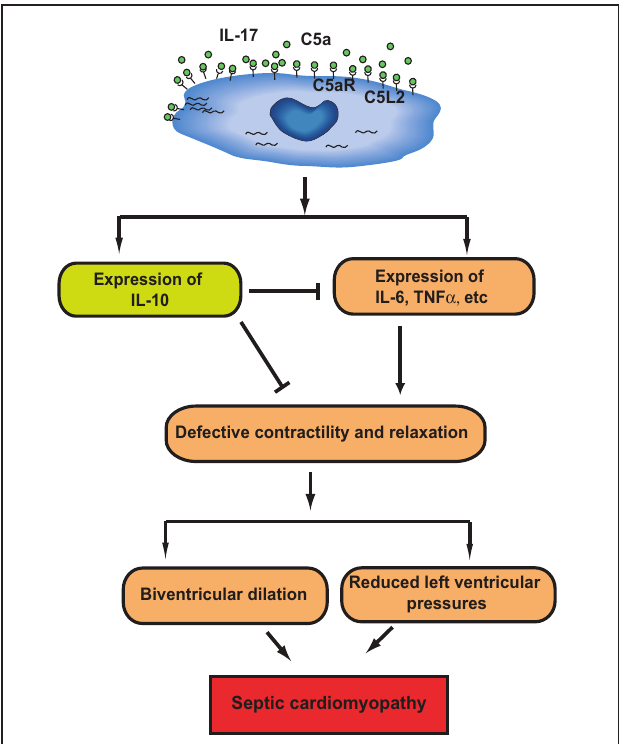
FIGURE 3 | Role of C5a signaling in cardiac dysfunction in sepsis. In cecal ligation and puncture (CLP)-induced sepsis, expression of C5aR, but not C5L2, on CMs is increased. C5a increased production of inflammatory mediators (IL-6, TNF- α , etc.,) and anti-inflammatory mediator (IL-10) from CMs in a C5aR-, C5L2-, and IL-17-dependent mechanism. The resulting cytokine storm impaired CM contractility leading to